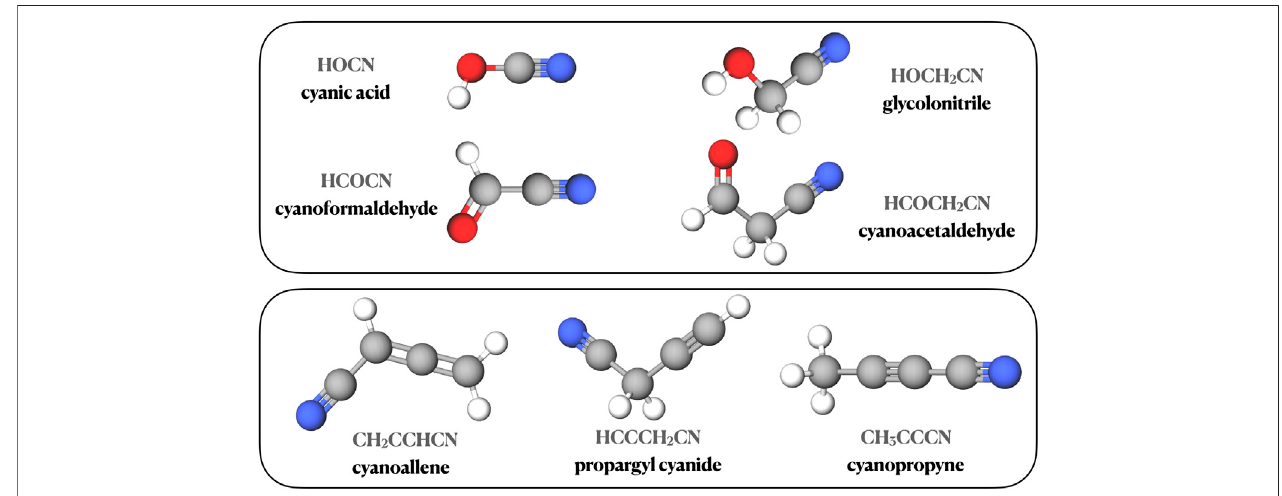
FIGURE 1 | Three-dimensional representation of the oxygen-bearing nitriles (upper panel) and the three C 4 H 3 N isomers (lower panel) analysed in this work. White, gray, red, and blue corresponds to hydrogen, carbon, oxygen and nitrogen atoms, respectively.